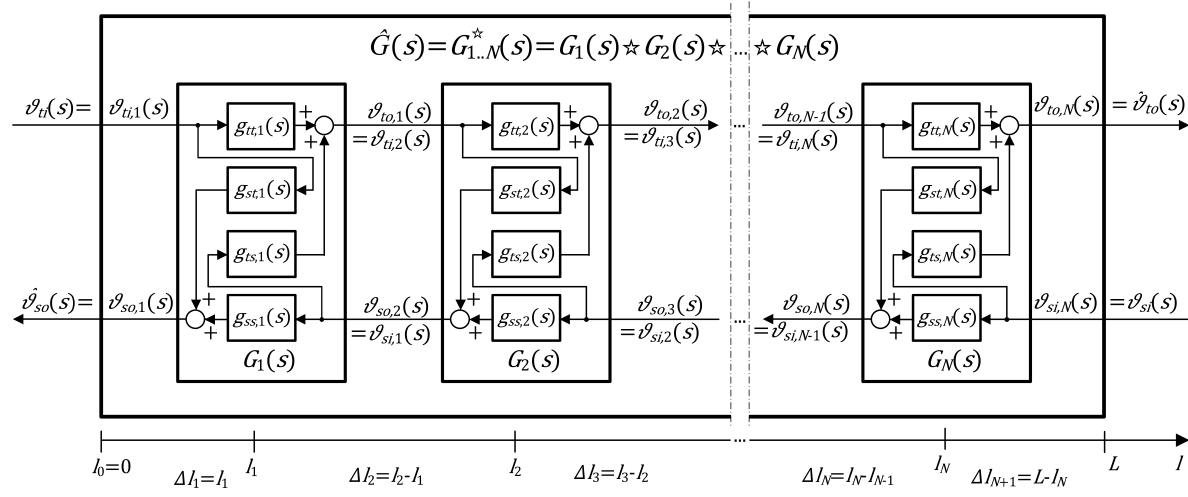
Figure 3. Block diagram of the approximate transfer function model for the double-pipe counter-flow heat